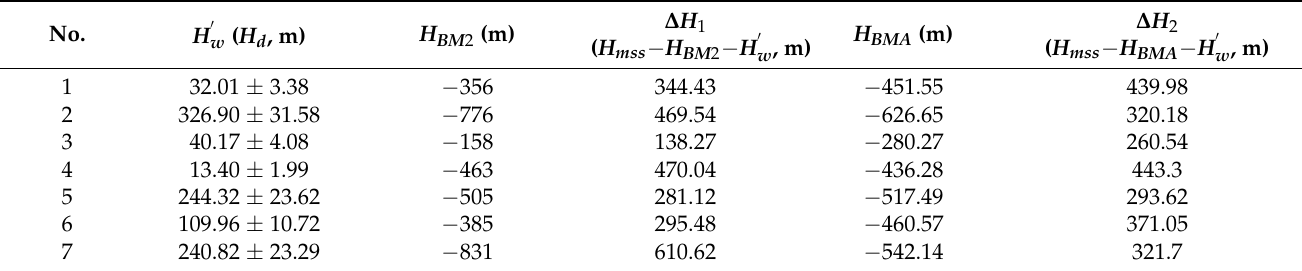
Figure 10. Illustration of an ideal cone-shaped iceberg. ( a ) Iceberg sketch and variables used. ( b ) Grounding points mapped onto the iceberg surface delineated from satellite image on 30 August 2020. Table 4. Iceberg draft ( H d ) at grounding points with the assumption of a conical shape below sea surface, which was also the maximum water depth ( H (cid:48) w ), and the corresponding seabed elevation BedMap2 ( H BedMap2 ) and BedMachine ( H BedMachine